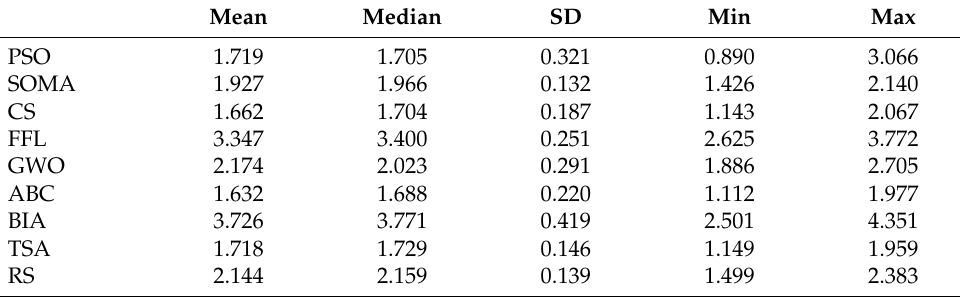
Table 5. Comparison of algorithms for Function f 5